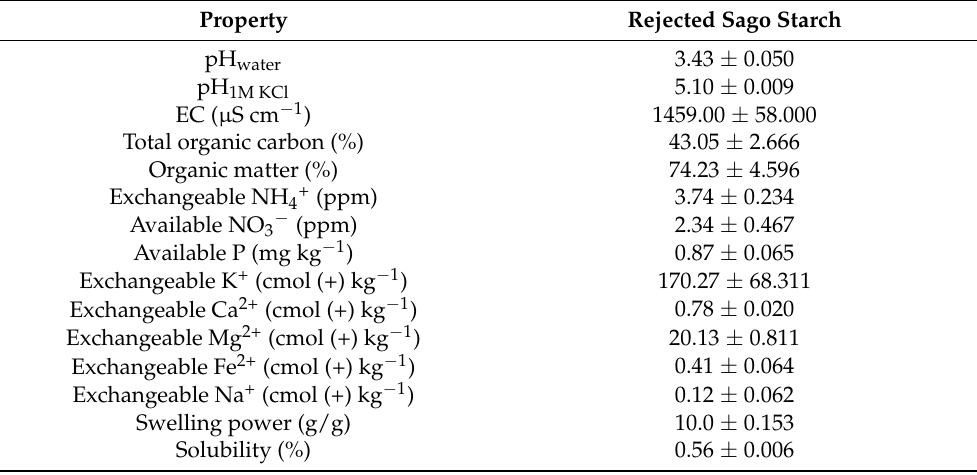
Table 3. Selected physical and chemical properties of rejected sago starch.